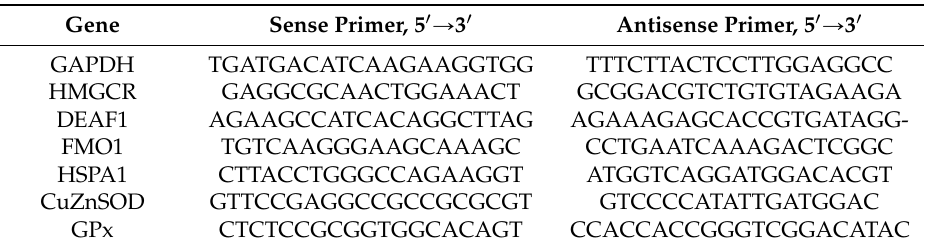
Table 3. PCR primers used for semi-quantitative